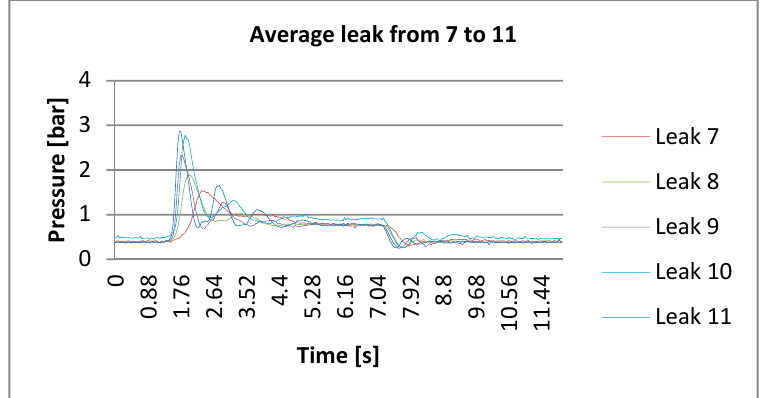
Figure 8. Recorded trends of opening and closing taps for simulating leaks from 7 to 11. Between 1.4 and 1.5 Hz, according to Figure 9 which represents the results of DLP processing of all signals in the time domain of leaks from 1 to 6, there is an interesting peak, the highest, that enables the best detection of the leak corresponding to water tap opening. The same reasoning is also done for Figure 10.